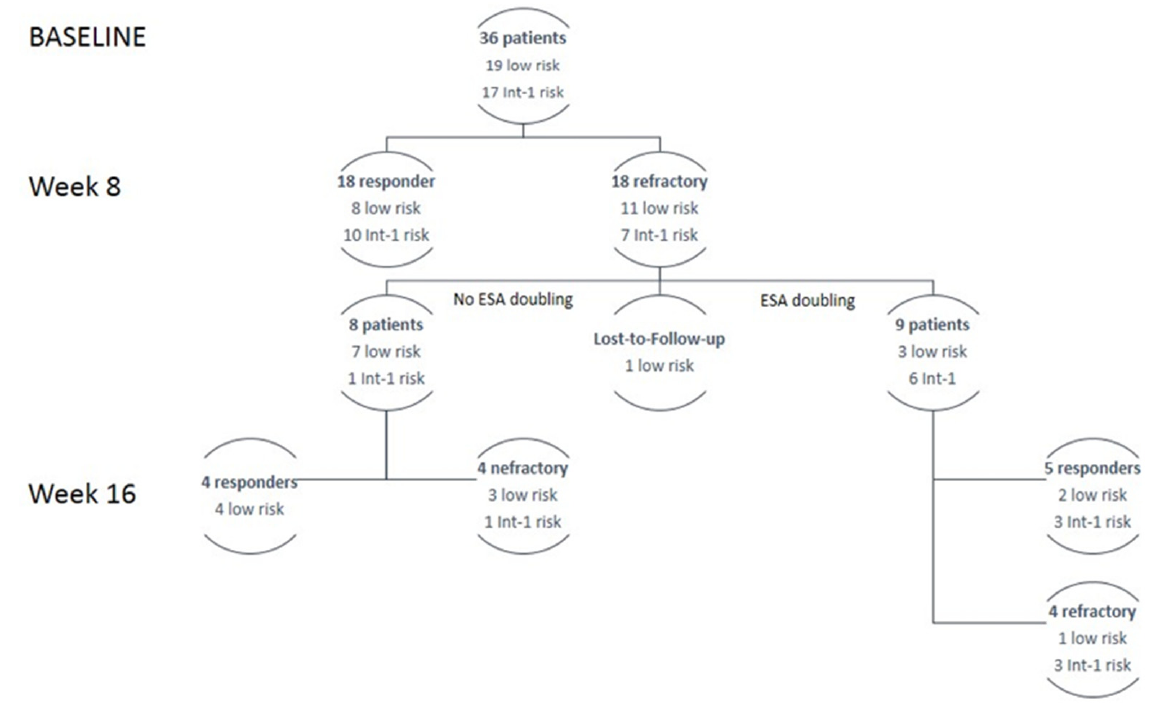
Figure 3. Patients flow according to treatment response and risk factors. ESA: erythropoietin stimulating agent.